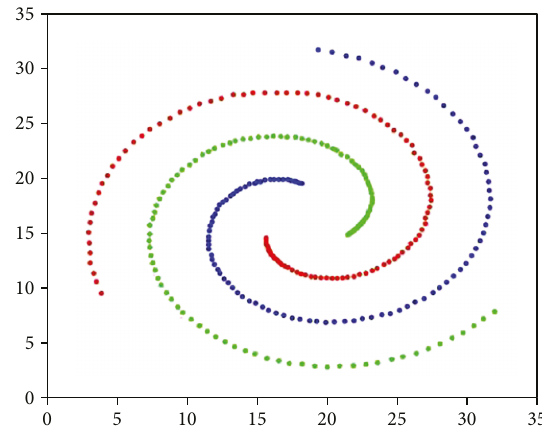
Figure 10: The distribution of points ’ roles when r is 0.21.